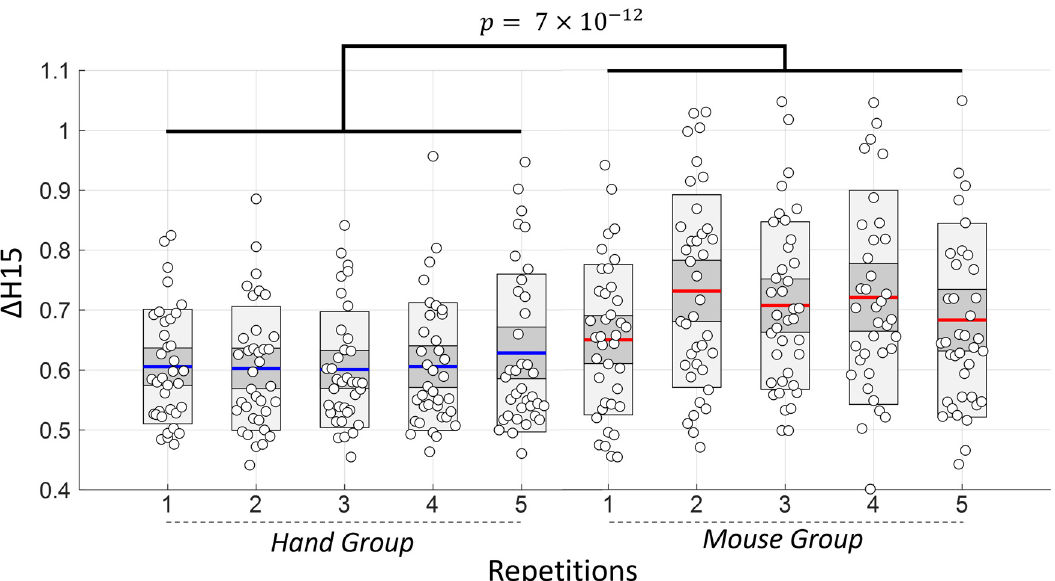
Figure 3. Multifractality as measured by ∆ H 15 (Equation (6)) in each of the five repetitions of the task for the two conditions: hand and mouse. Colored lines indicate mean, heavy grey ± 1SD and light gray 95% confidence interval. Individual values are represented by white circles.